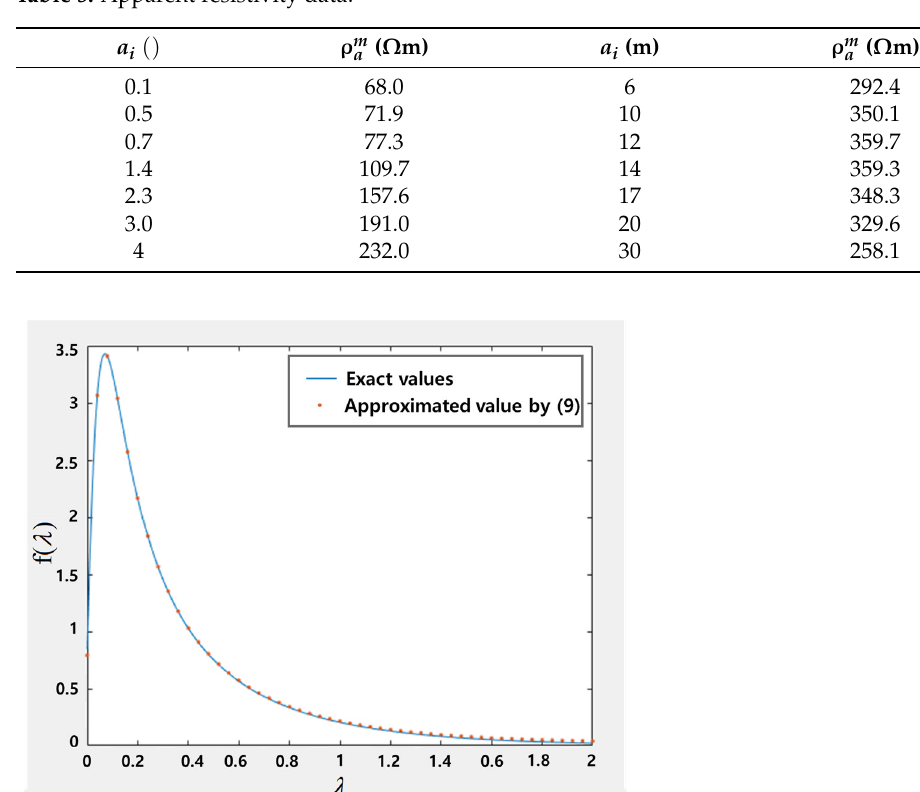
Table 5. Apparent resistivity data.